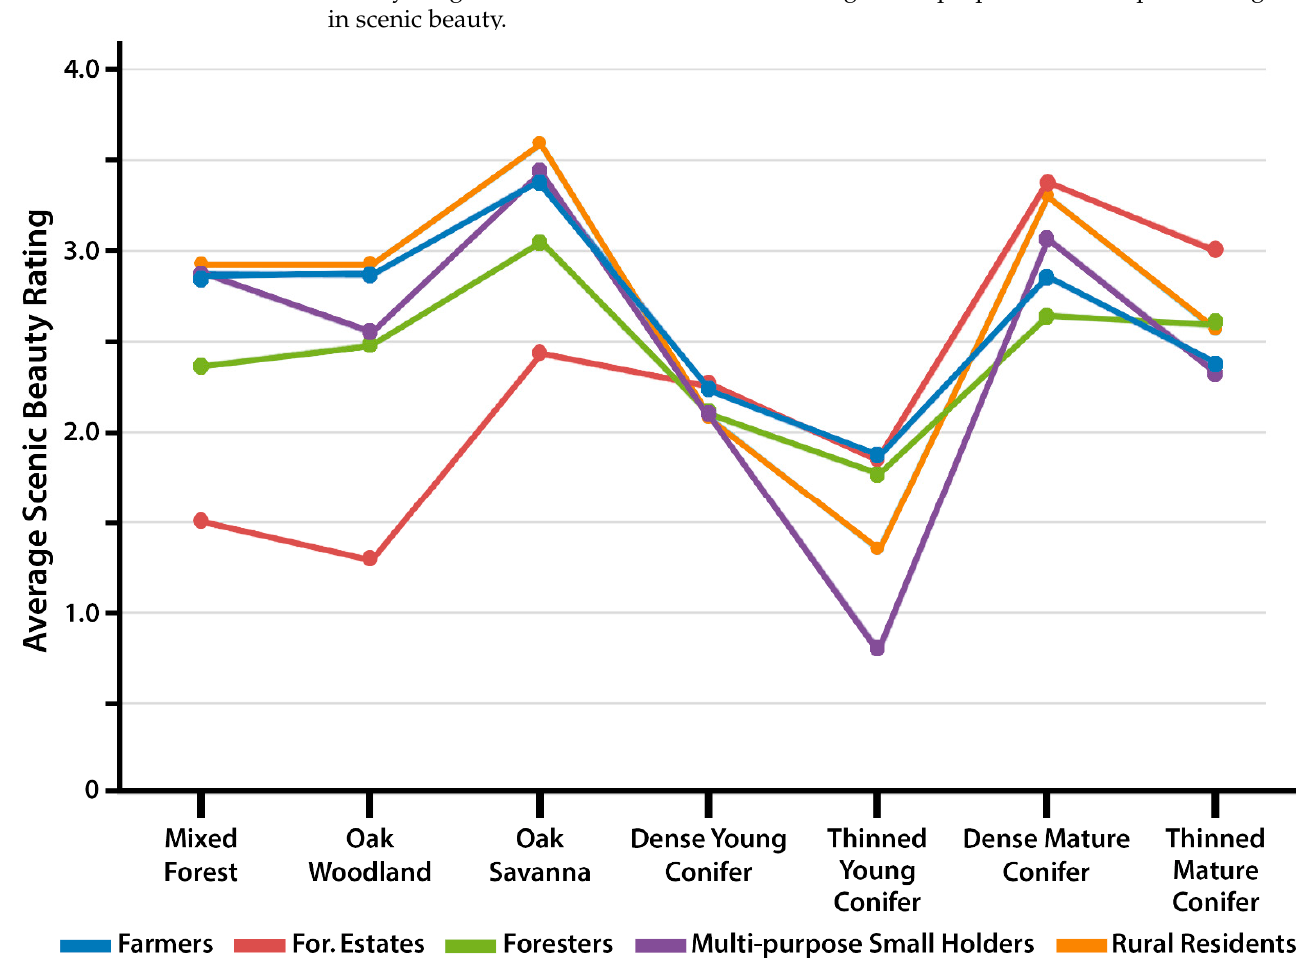
Figure 12. Average scenic beauty ratings of forest types by landowner categories.